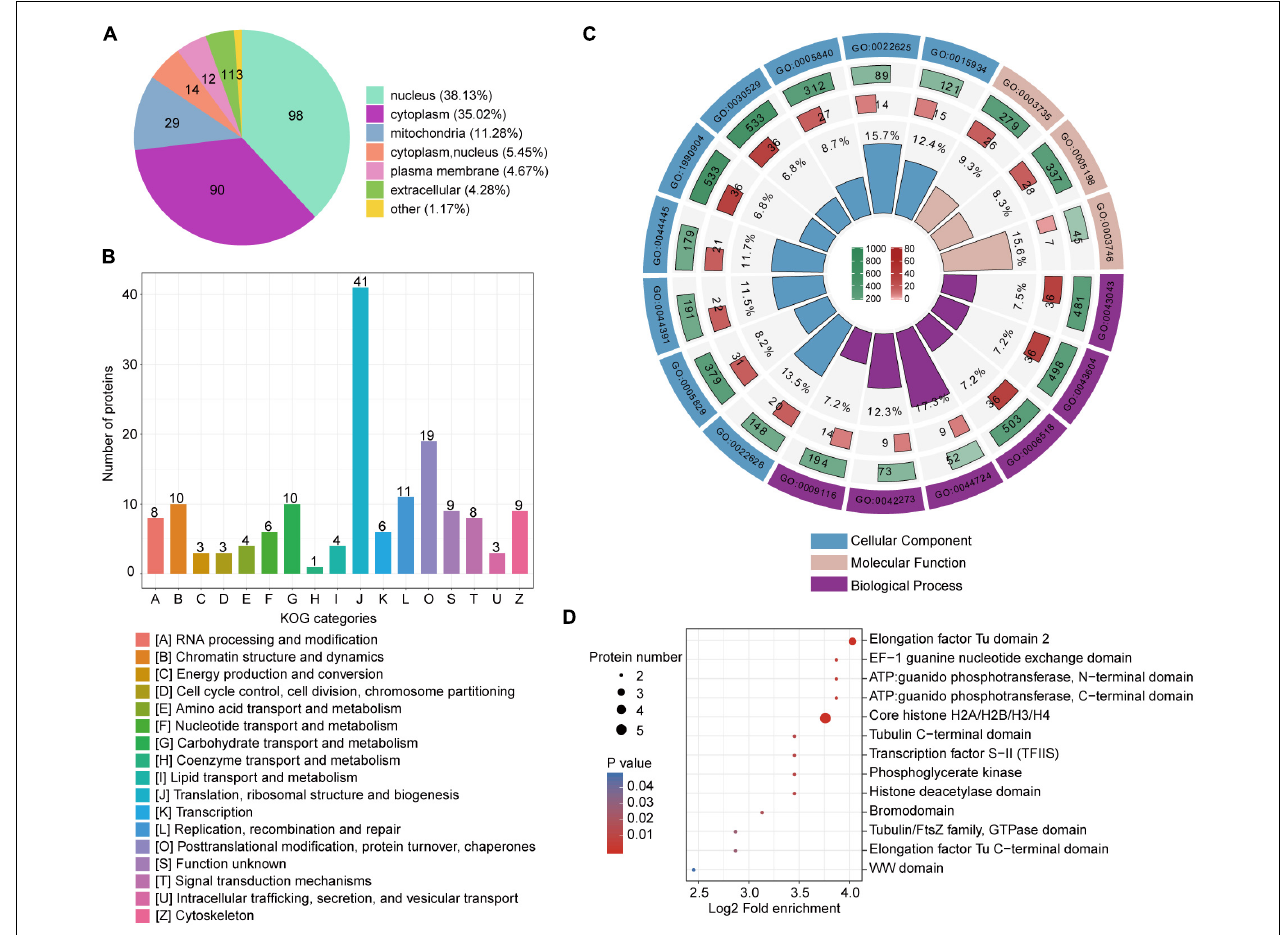
FIGURE 1 | Compartmental Kla protein distribution and enrichment analysis. (A) Pie chart indicating subcellular lactylated protein localization. (B) KOG functional classification of identified lactylated proteins. (C) Enrichment analysis of GO items. From outside to inside: items, number of background proteins, number of identified proteins, and degree of enrichment. (D) Bubble plot displaying domain enrichment of lactylated